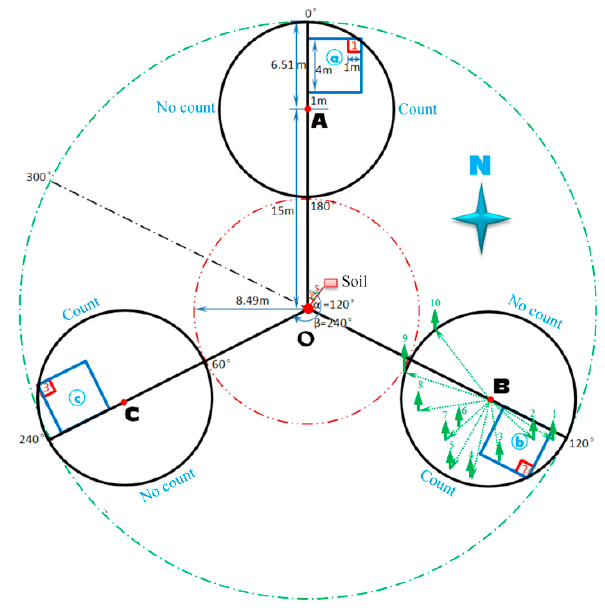
Figure 2. Sample plot design of the Tropical Forestry Experimental Centre.